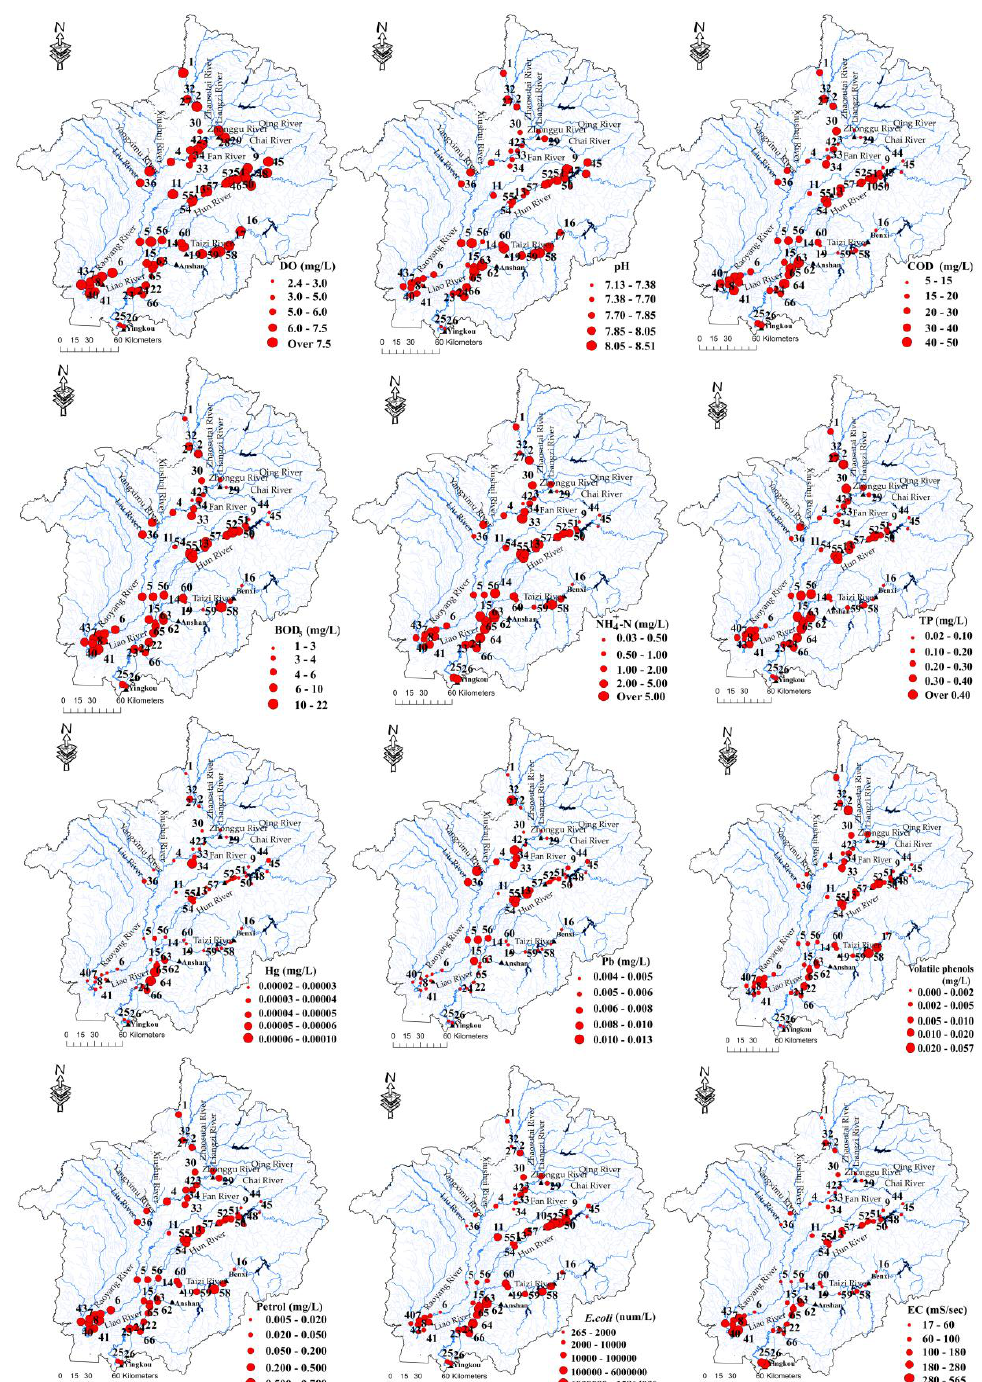
Figure 6. Spatial variations in DO, pH, COD Mn , BOD 5 , NH 4+ –N, TP, Hg, Pb, volatile phenols, petrol, E. coli and EC in the study area. Note: EC = electrical conductivity.